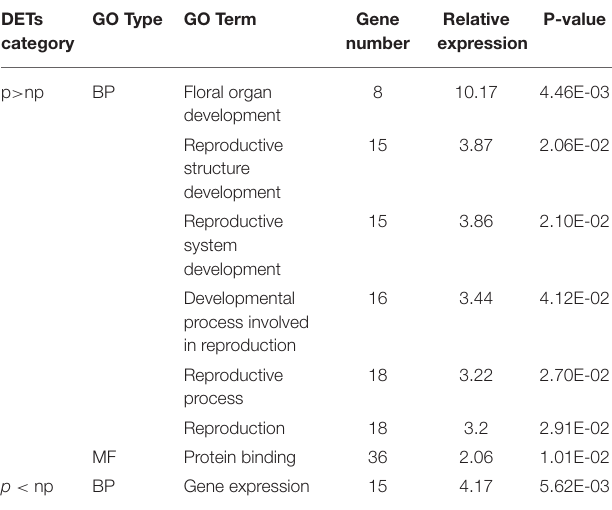
TABLE 3 | Significantly enriched GO terms in differentially expressed transcripts (DETs) identified in the anthers (collected from the bud size, 11–14mm) of pollen-sterile (np) and fertile (p)